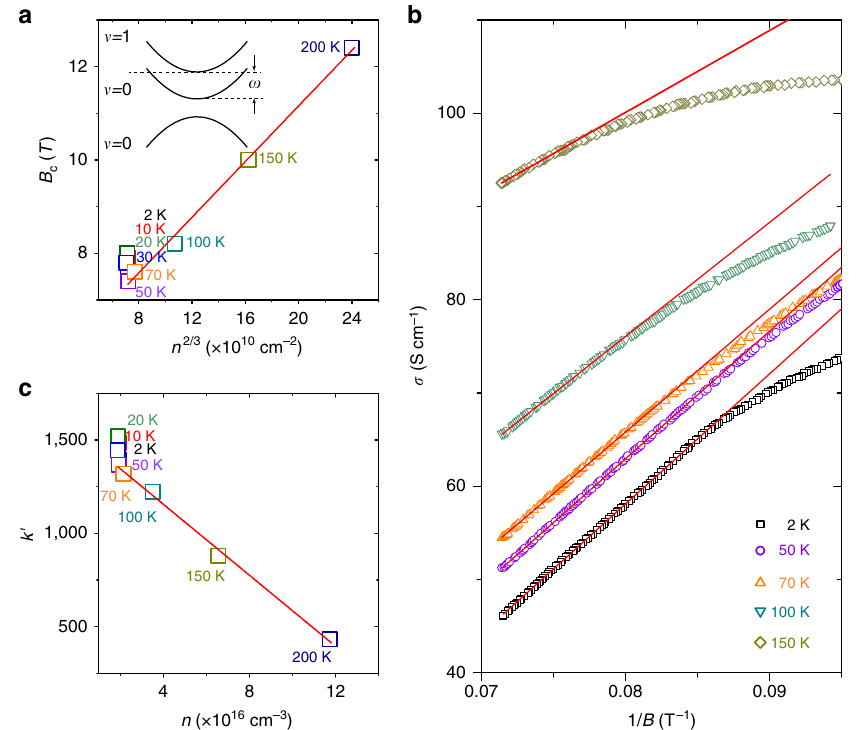
Figure 5 | MR in the quantum limit. ( a ) B C as a function of n 2/3 , n is the carrier density. The corresponding temperature for each data point is also indicated. The solid red line is a linear fitting. B C is defined as the critical field at which the MR in B parallel to E is minimum. At B C , the system enters the quantum limit with a structure of the Landau bands illustrated as in the inset. v is the index of the Landau bands and o is the cyclotron frequency. ( b ) The high- B -field magnetoconductivity in B parallel to E as a function of 1/ B . The magnetoconductivity is found to follow a k 0 / B dependence while approaching 14T (see solid red lines). ( c ) The slope k 0 as a function of the carrier density. The solid red line is a linear